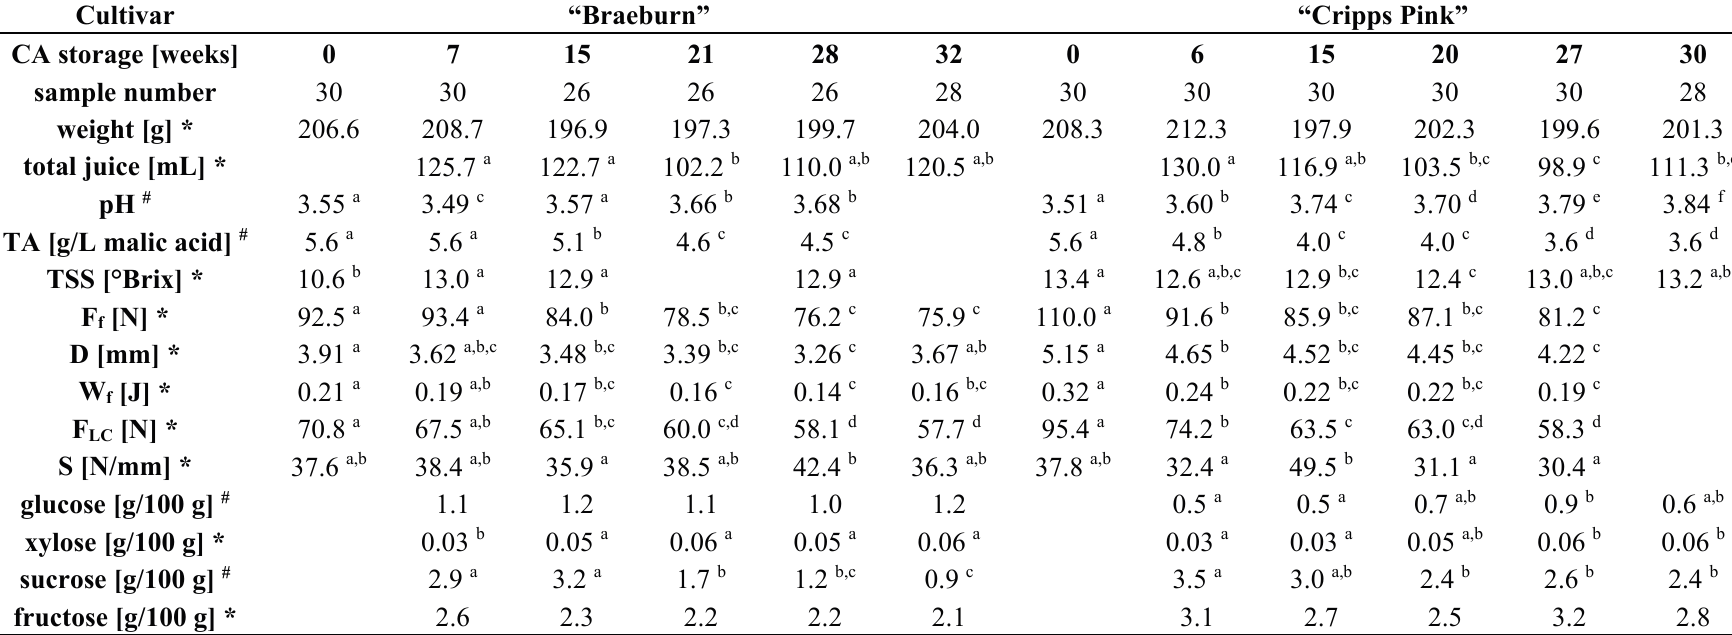
Table 2. Post-harvest evolution of quality parameters (mean) of “Braeburn” and “Cripps Pink” apples from the optimum harvest date (HT1) during long-term CA